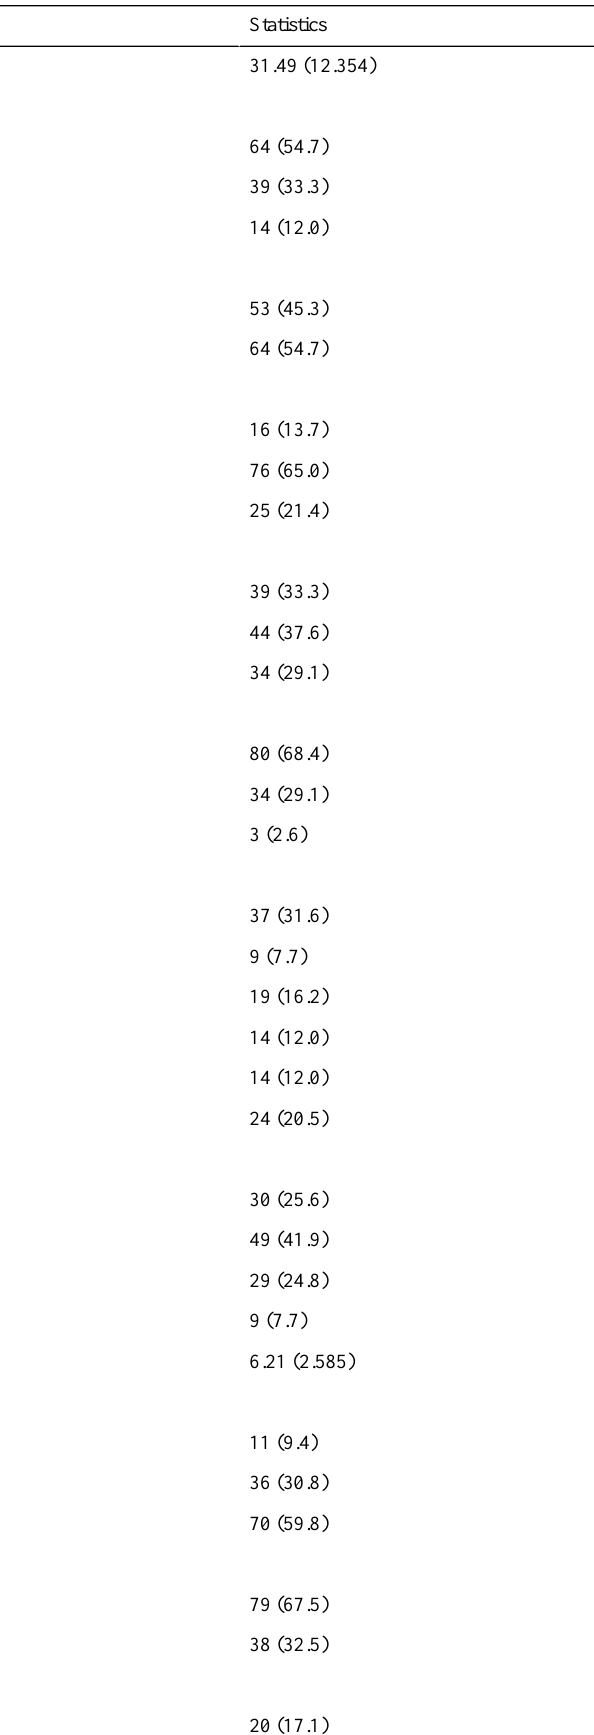
Table 1. Demographic characteristics of the study participants